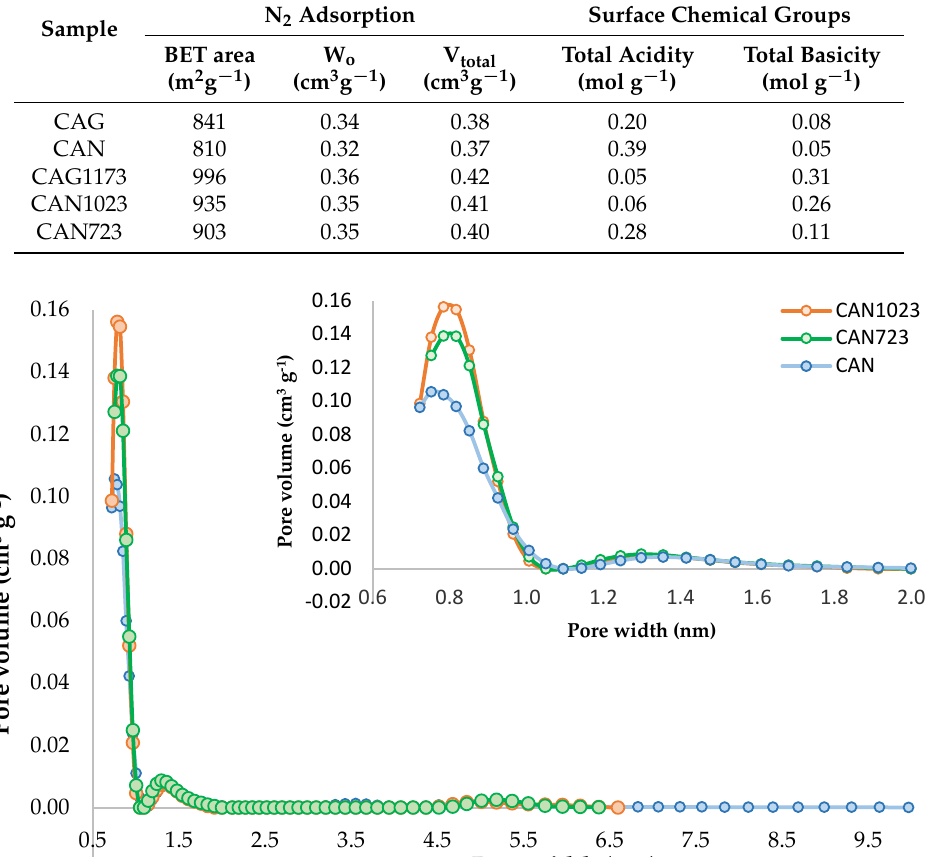
Table 1. Textural and chemical characteristics of activated carbons.